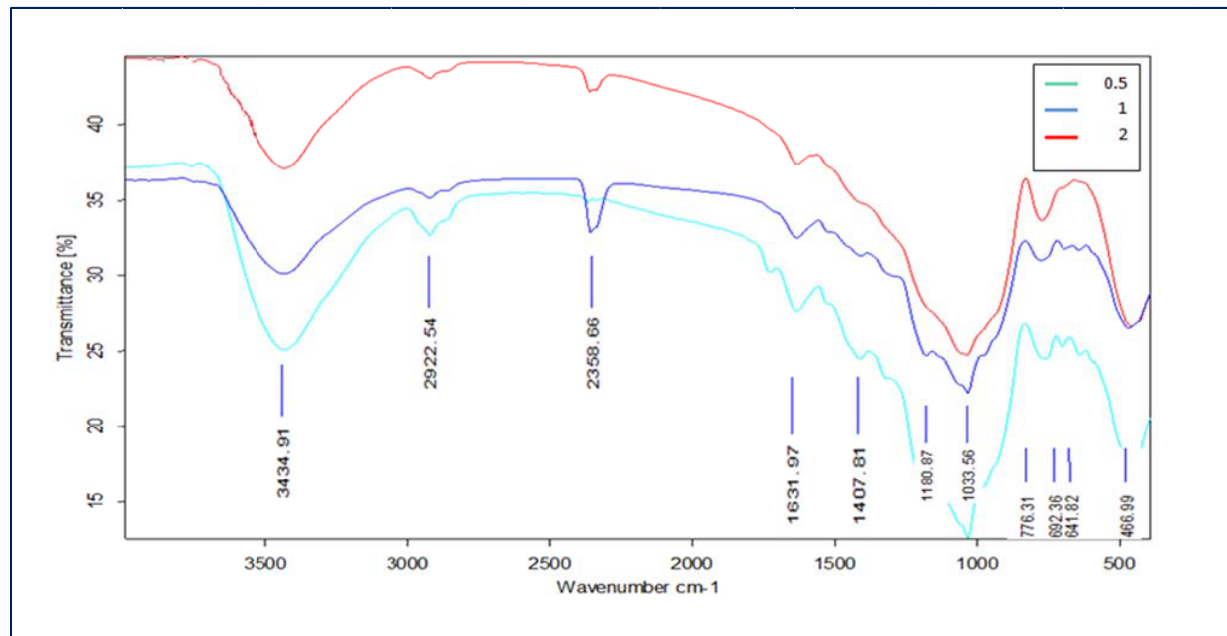
spectra for N NiPcTs/ PED DOT:PSS ble oncentration